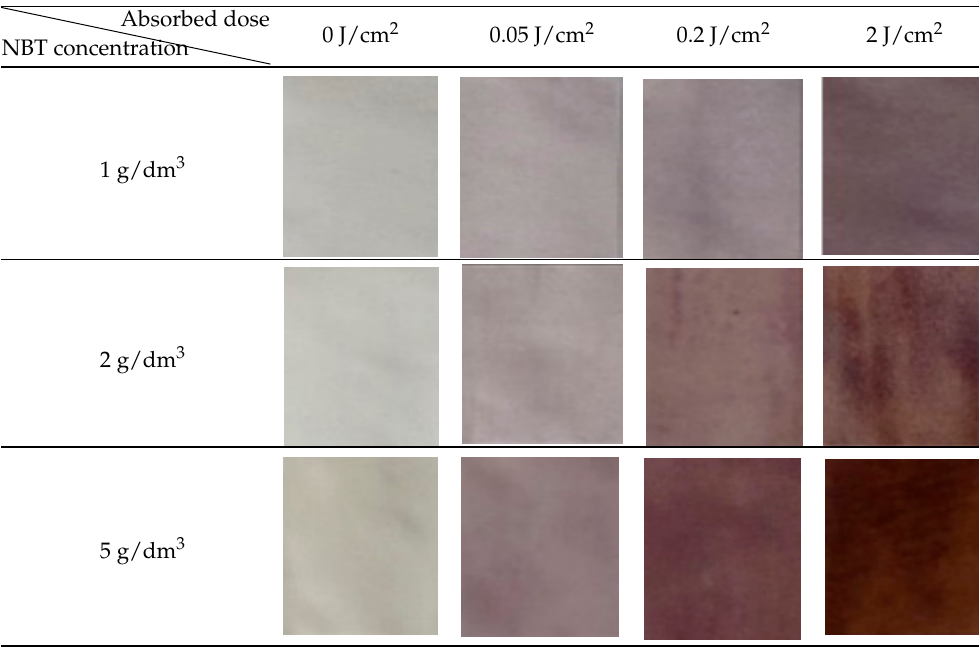
To assess the effect of the textile substrate type on dose response, the polyamide and cotton samples were printed with NBT-Pluronic F-127 hydrogel containing 1g/dm 3 NBT